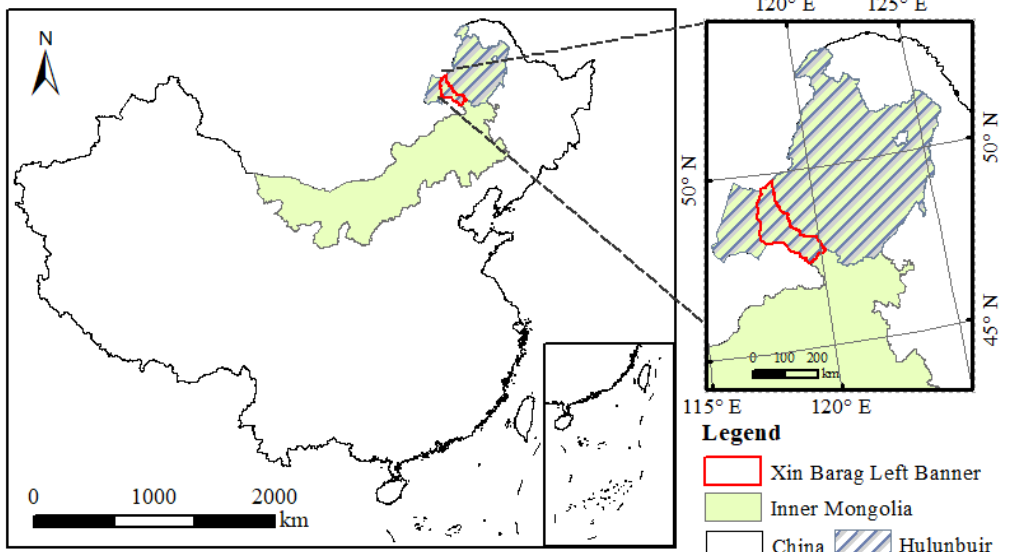
Figure 1. Location of Xin Barag Left Banner.